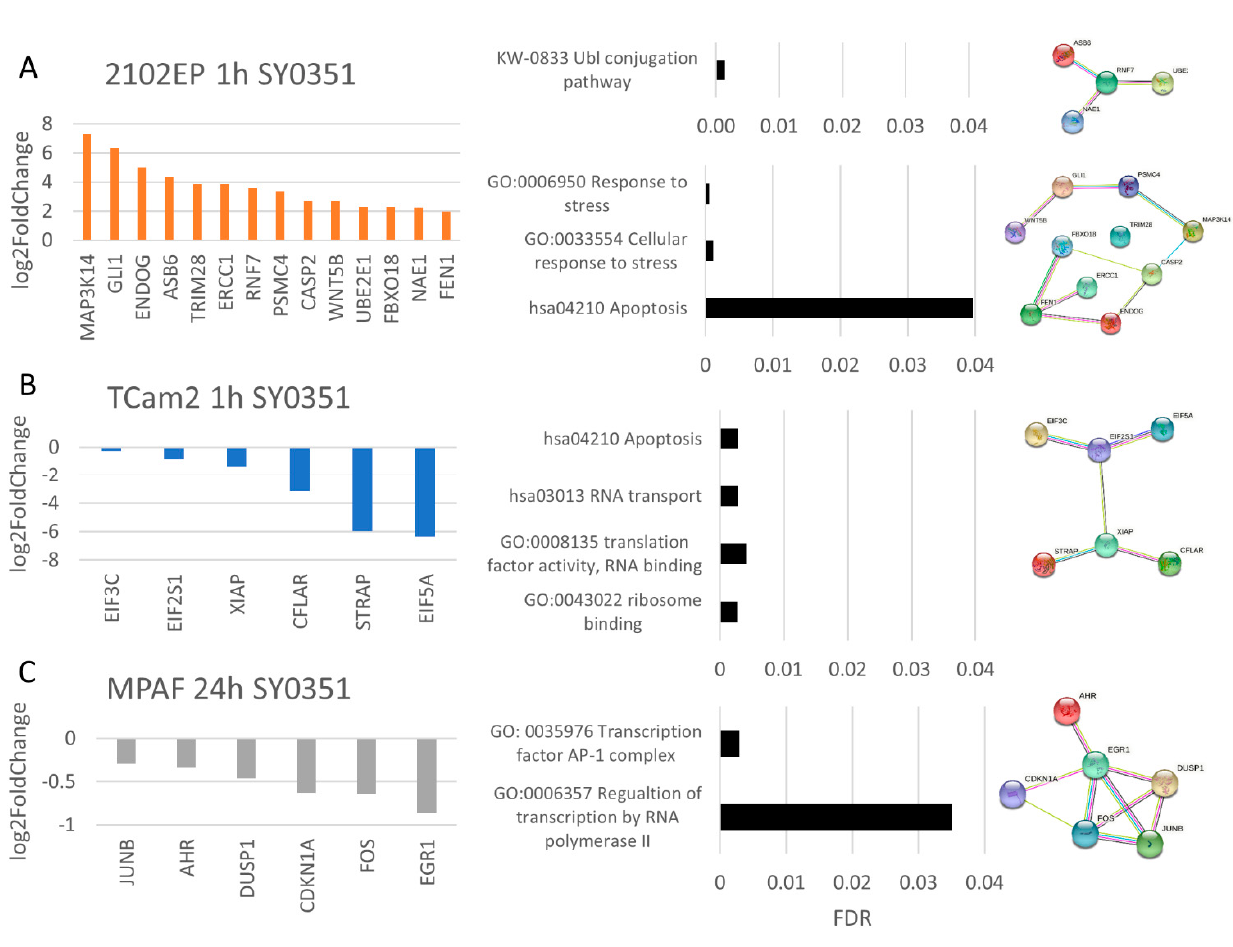
Figure 6. SY0351 treatment reveals cell-line-specific response. RNA-seq data after SY0351 treatment (10 nM) shown as differential expression, GO and STRING analysis for ( A ) 2102 EP (1 h), ( B ) TCam2 (1 h) and ( C ) MPAF (24 h). For all samples, n = 3.